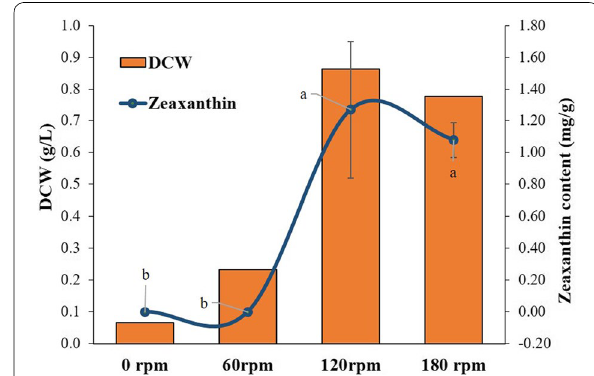
Fig. 6 Effect of shaking conditions on the zeaxanthin accumulation by A. gandavensis MTCC 25325 after 72 h of incubation. All statistical significance comparisons between indicated groups were performed using a one-way ANOVA with Fisher’s post-test. Data presented are mean values and their standard